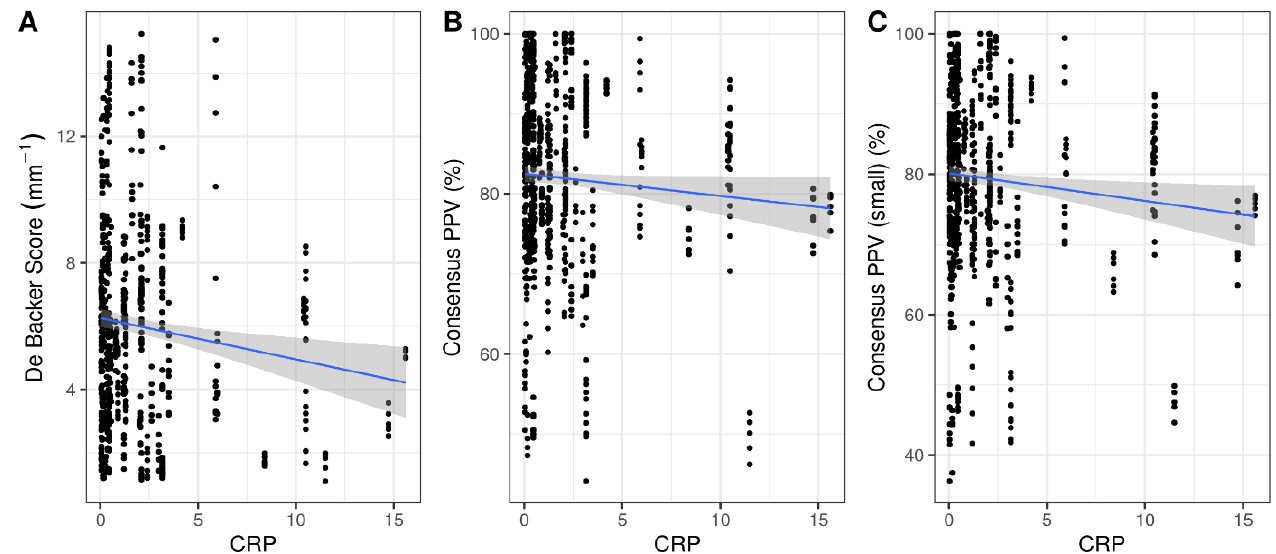
Figure 1. Correlation of preoperative CRP with De Backer score (mm − 1 ) ( A ), Consensus PPV (%) ( B ),